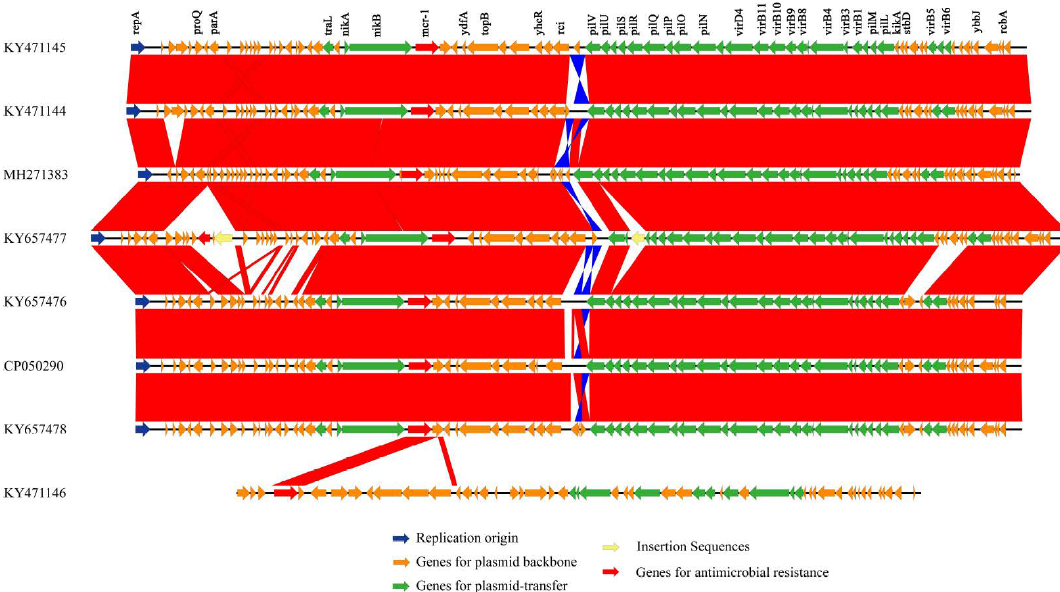
Figure 3. Comparative analyses of the mcr-1 -carrying plasmids from E. coli strains isolated from food animals, humans, and a dog. The sequence of each plasmid (Table 1) was aligned using Blastn (v 2.8.1) and compared using EasyFig (v.2.2.3). Highly conserved regions ( > 96% identity value) with normal alignment are indicated in red, and regions with inverted alignment are indicated in blue.